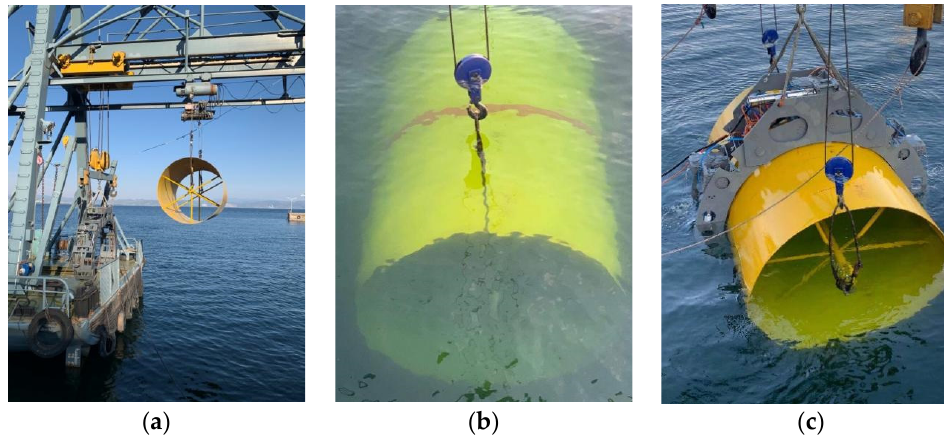
Figure 15. Lake test of the manipulator prototype: ( a ) Launch the object at the test point, ( b ) The object wad dipped into the water and ( c ) Lift the object out of the water.